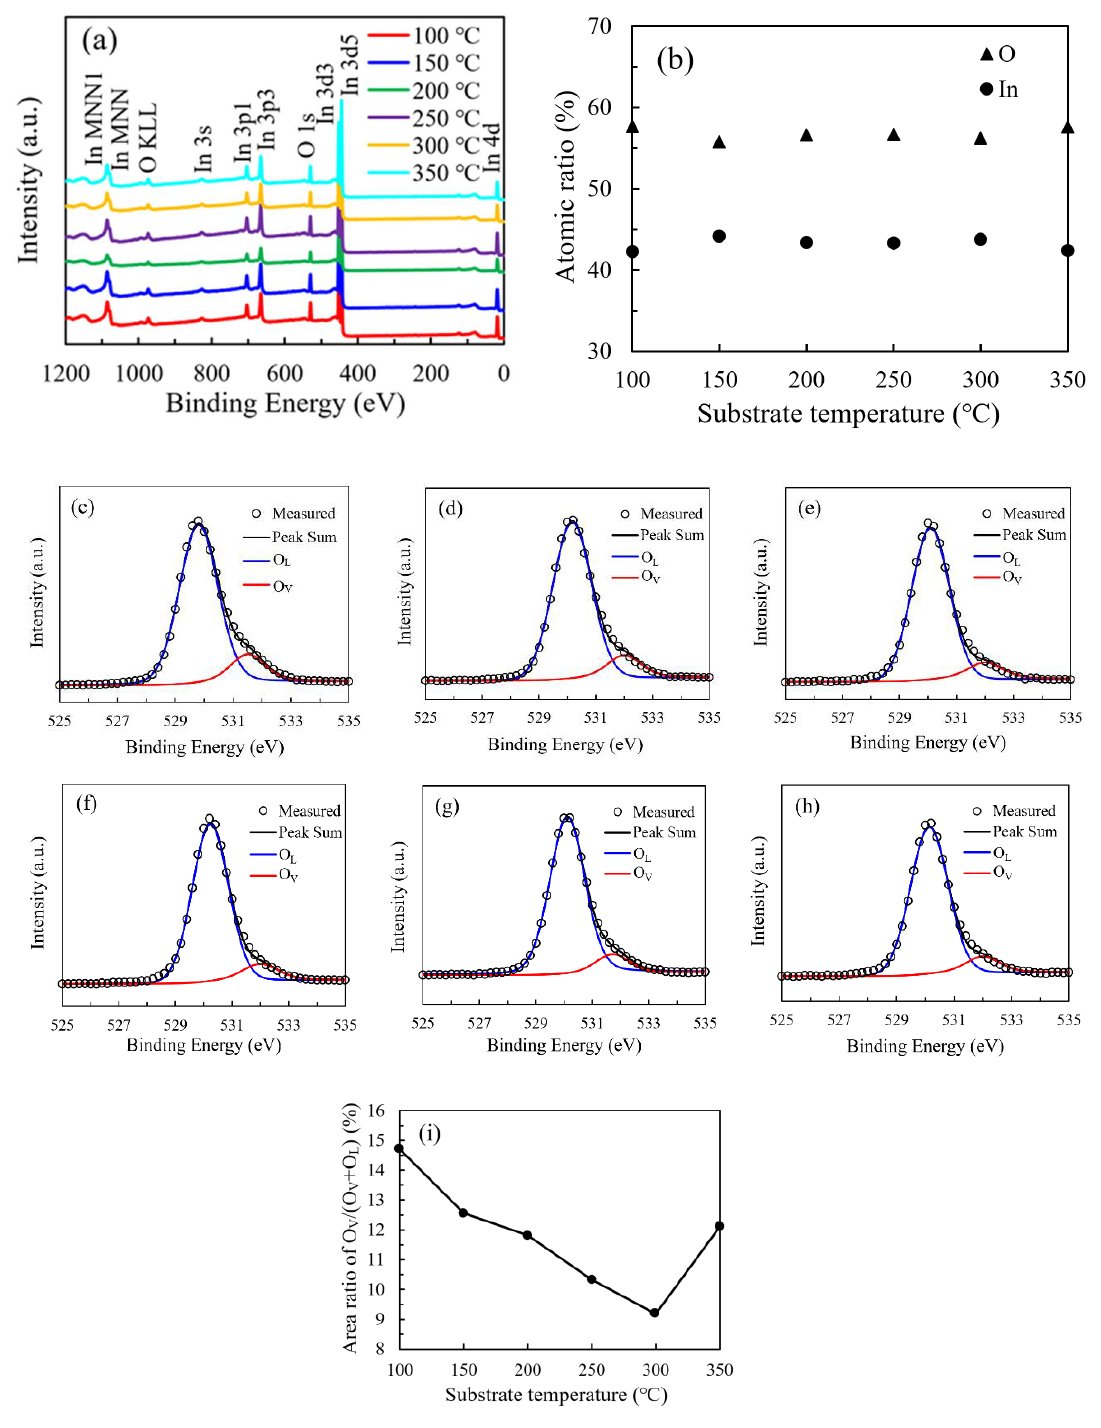
Figure 7. ( a ) The broadly surveyed XPS spectra of the In 2 O 3 films; ( b ) the variation in the relative atomic ratio of In and O elements with substrate temperature; ( c – h ) the high-resolution spectra of O 1s peak of the PEALD-In 2 O 3 films deposited at 100 – 350 °C; ( i ) the variation of area ratio of O V /(O V +O L ) with substrate temperature.